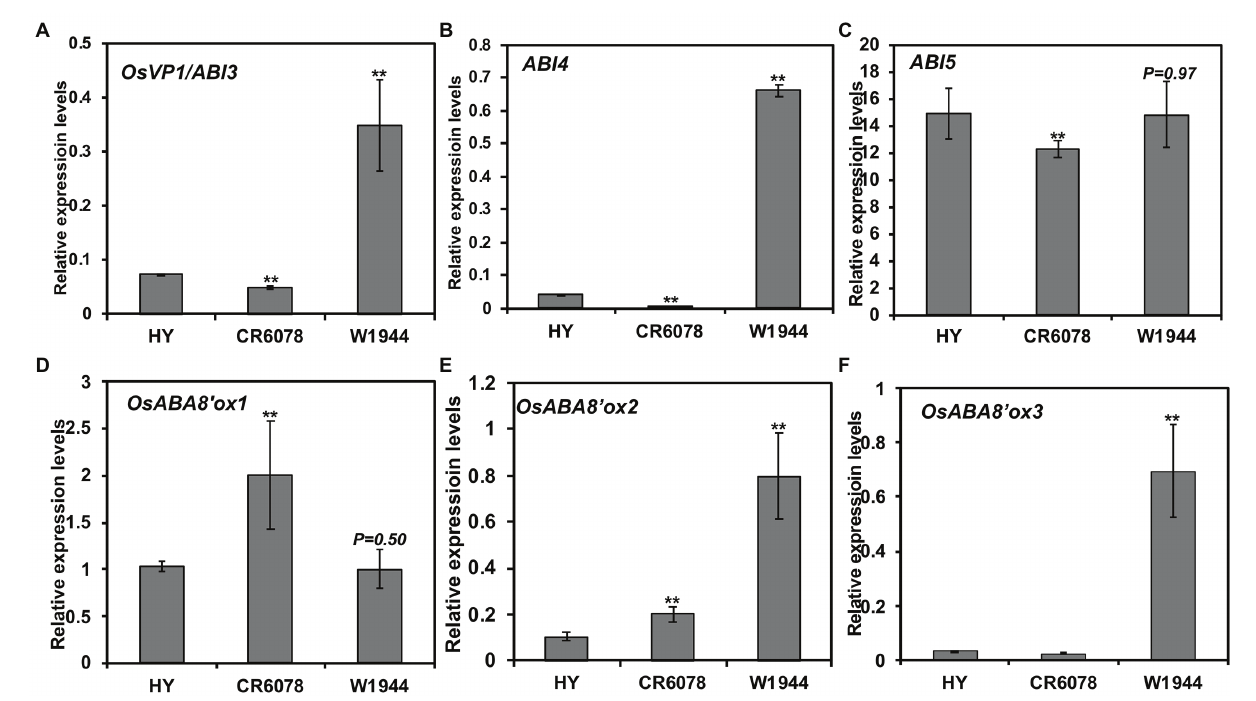
FIGURE 6 | Expression of abscisic acid (ABA) signal transduction and ABA catabolism-related genes in three accessions (A–F) . Seeds from the three lines were used to isolate the total RNA. Relative expression level of each gene was quantified using real-time PCR and normalized using OsTMP1 as an internal control. The error bars represent mean ± SD ( n = 3). The significant differences between the HY and each OX line and the CR6078 plants and each RNAi line were evident at ** p < 0.01.